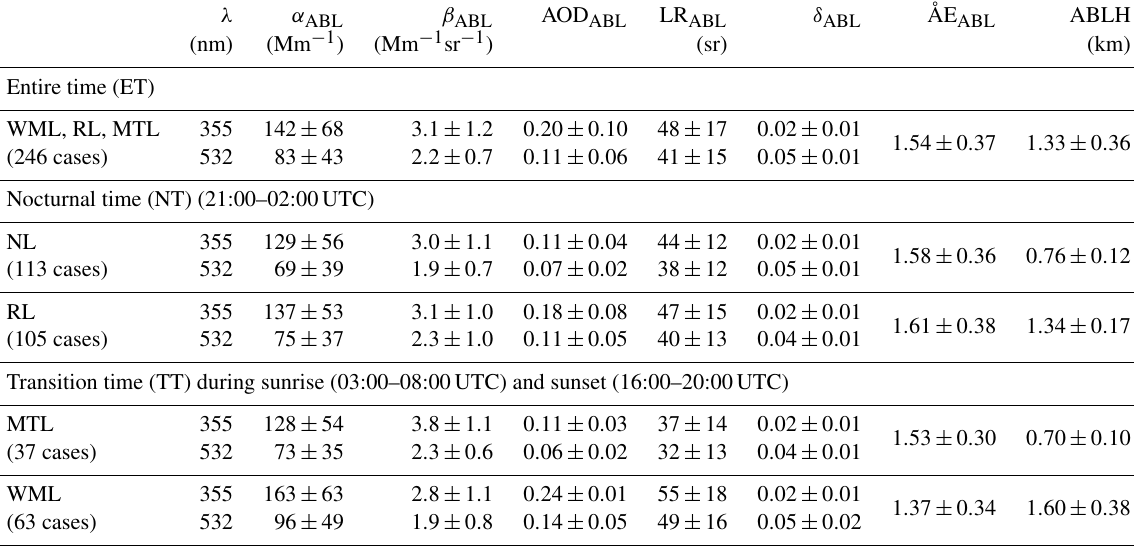
Table 2. Mean values of the aerosol optical properties with standard deviations derived within the atmospheric boundary layer (ABL) from the PollyXT lidar at the EARLINET site, Warsaw, for measurements at 355 and 532nm conducted for the July–September period of 2013, 2015, and 2016. Symbols denote the particle extinction coefficient ( α ), the particle backscatter coefficient ( β ), the aerosol optical depth (AOD), the lidar ratio (LR), the linear particle depolarization ratio ( δ ), the Ångström exponent (ÅE), and the atmospheric boundary layer height (ABLH). Mean values are obtained for different times of the day with respect to the boundary layer type. λ α ABL β